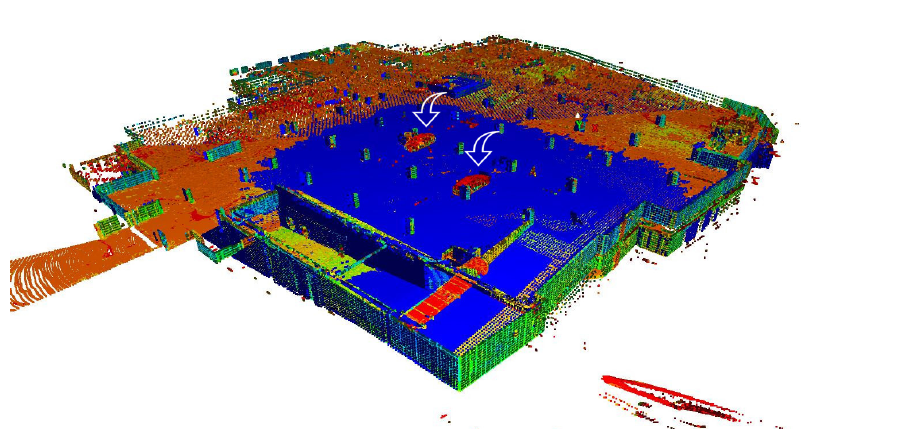
Figure 19. Snapshot of mutually-registered NavVis (blue) and TLS (other colors, by height) point clouds from the car park. The ramp up is shown at the bottom of the image. The second floor ceiling has been cut off for visual purposes. Red outliers are from the TLS cloud; these include two cars that have left the scene and are marked with white